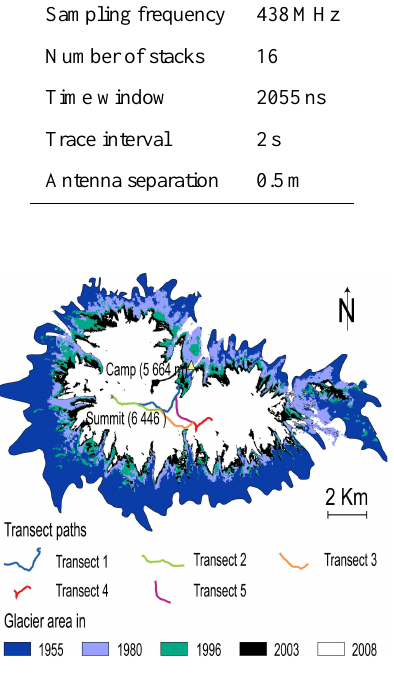
Fig. 2. Georeferenced radar profiles and evolution of glaciated area